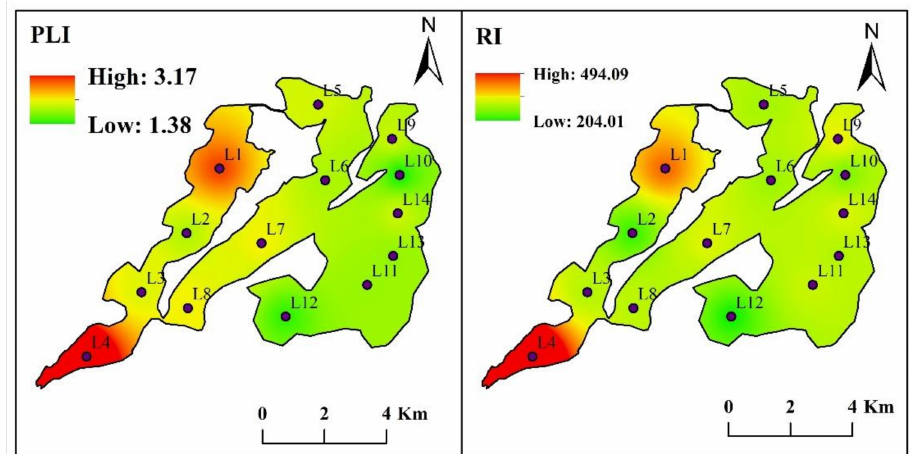
Figure 7. The spatial distributions of PLI and RI in the surface sediment according to the values of 14 sampling sites in Lake Yangcheng. The colored areas indicate risk values at the sampling sites. The color spectrum ranges from green (lowest) to red (highest).